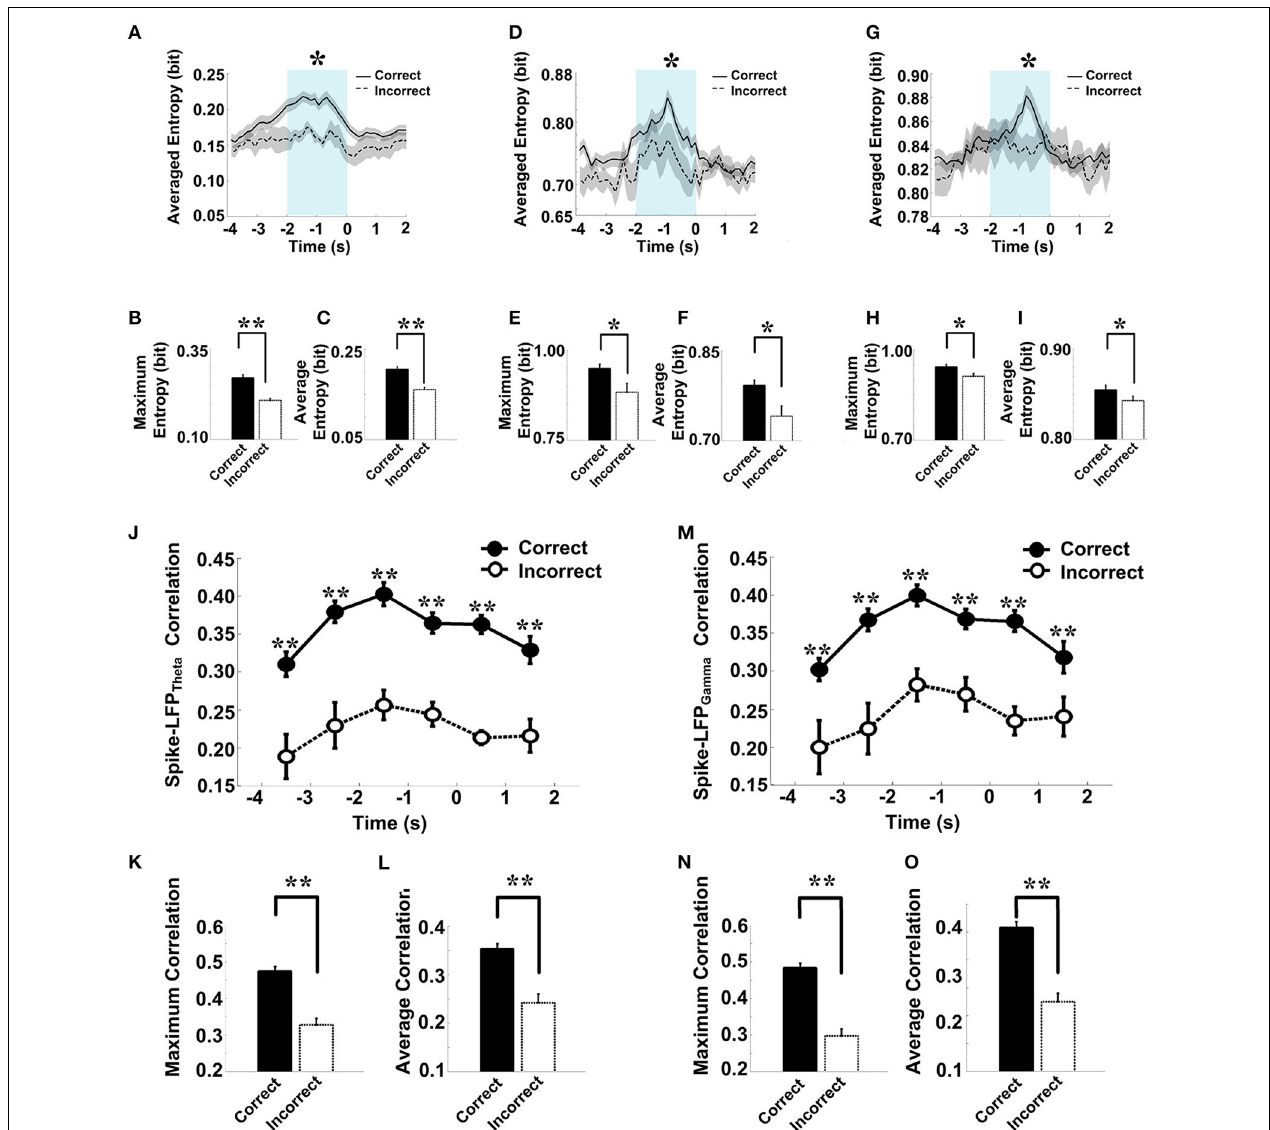
FIGURE 9 | Spike-LFP coordination in correct ( n = 56) and incorrect ( n = 10) trials in the control group. (A) Averaged spikes entropy across correct (solid) and incorrect (dashed) trials. The shaded region indicates s.e.m. The light blue area indicates the period used for statistical analysis. Averaged entropy values were compared in this time window ( ∗ P < 0 . 05, ∗∗ P < 0 . 01). (B) Peaks of spike entropy. (C) Averages of spike entropy. (D) Averaged entropy of LFP theta in correct and incorrect trials. (E) Peaks of LFP theta entropy. (F) Averages of LFP theta entropy. (G) Averaged entropy